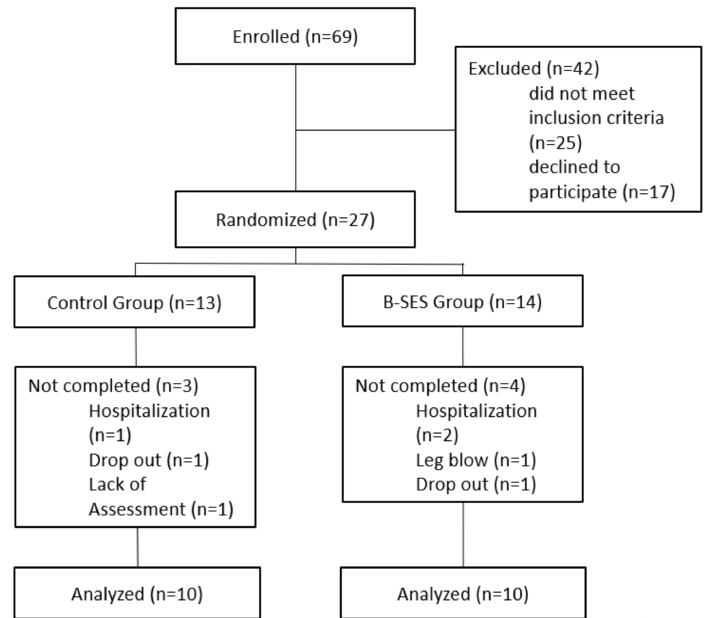
Figure 3. Study flow chart. Among the 69 patients who were screened for eligibility, 42 patients were excluded because of their physical function/medical assessment results or because they declined. Therefore, a total of 20 patients (10 in the control group and 10 in the B-SES group) were included in the final analysis.